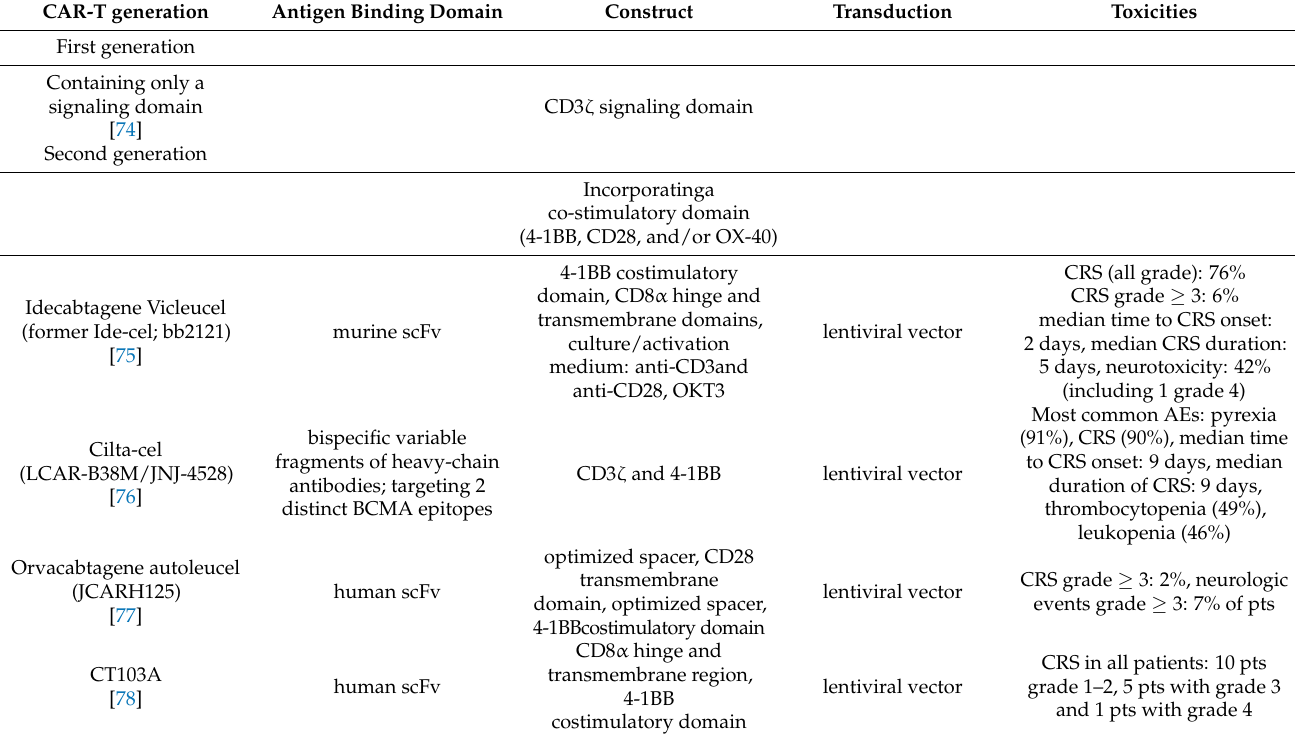
Table 3. Characteristics of selected first and second generation CAR-T